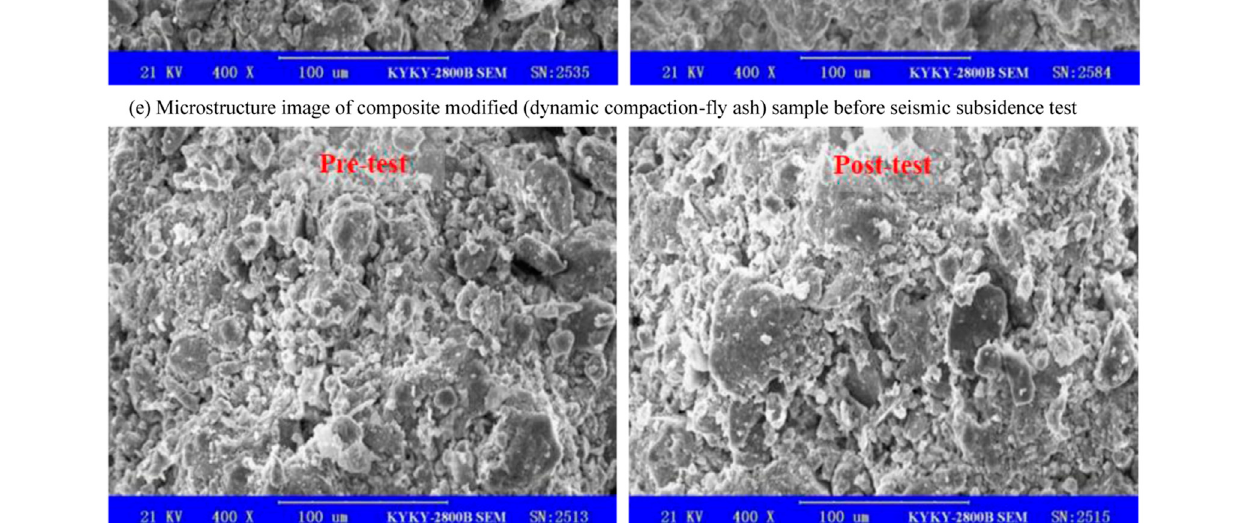
structure showed that the surface of the soil particles is covered with unique spherical particles, that is, glass beads with a content of more than 70% in the fl y ash. These microbeads